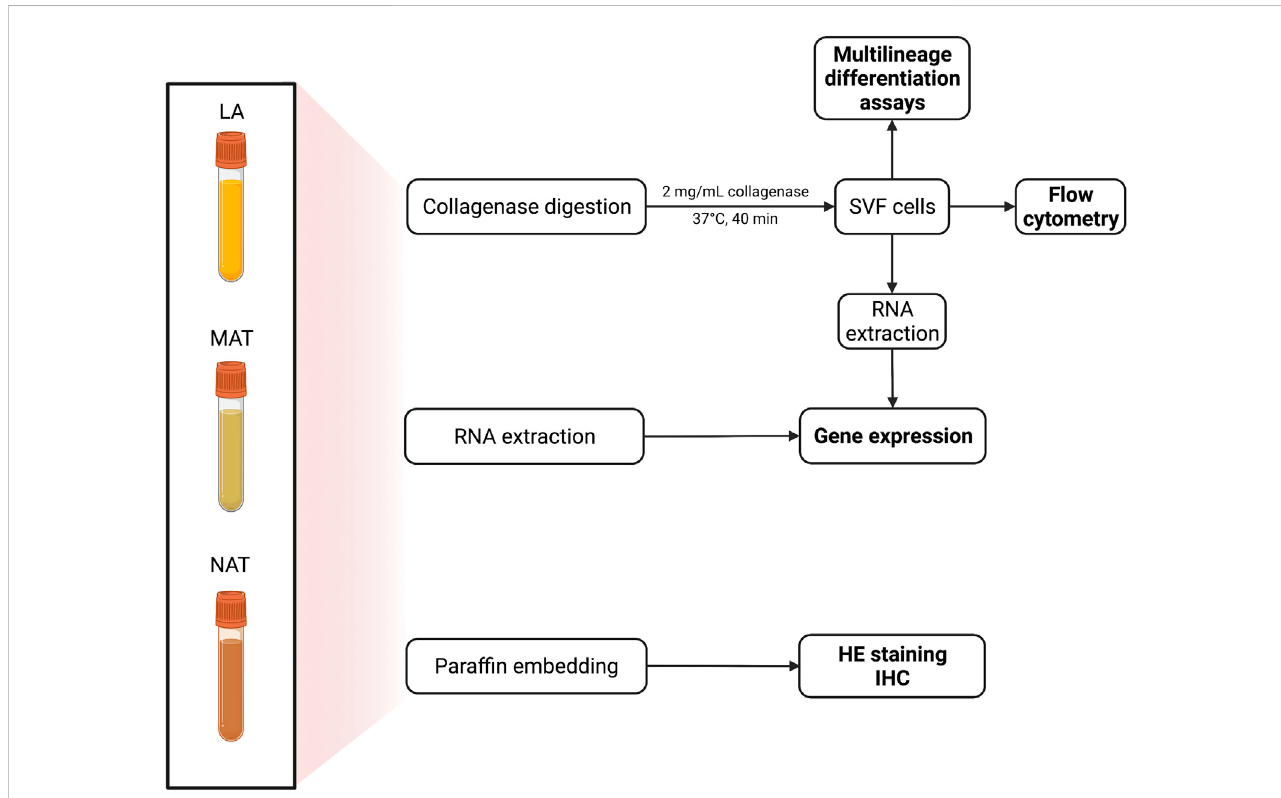
FIGURE 1 Schematic procedure for the processing of adipose tissue (AT) from lipoaspirate (LA), micro-fragmented (MAT) and nanofat (NAT) samples. Specimens weredividedintothreealiquots:3 mlforcollagenasedigestion;1 mlforRNAextractionand1 mlforparaf fi nembedding.Stromalvascularfraction(SVF)pellet ( n = 2 for each group) was alternatively used to isolate adipose-derived stem cells